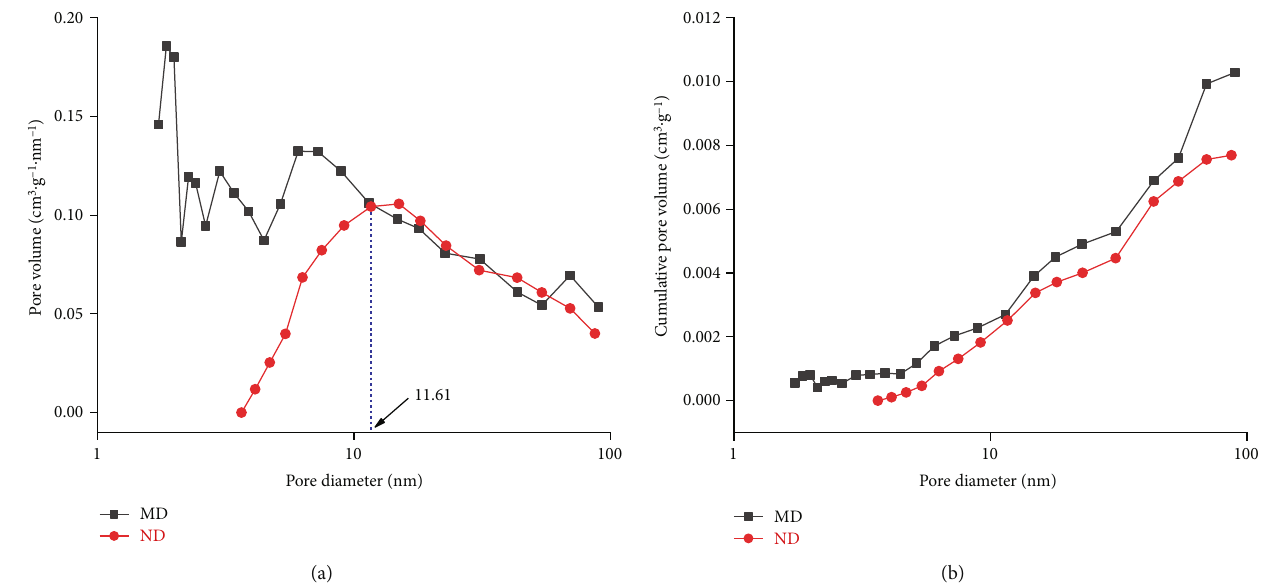
Figure 6: The distributions of pore sizes and cumulative pore volumes of MD and ND.